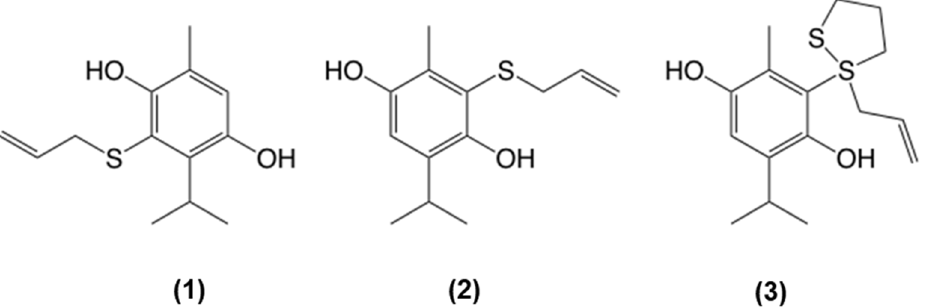
Figure 4. The structure of reactants between BCO and AM. 1 : 3-Allylthiodihydrothymoquinone, 2 : 2-Allylthiodihydrothymoquinone, 3 :